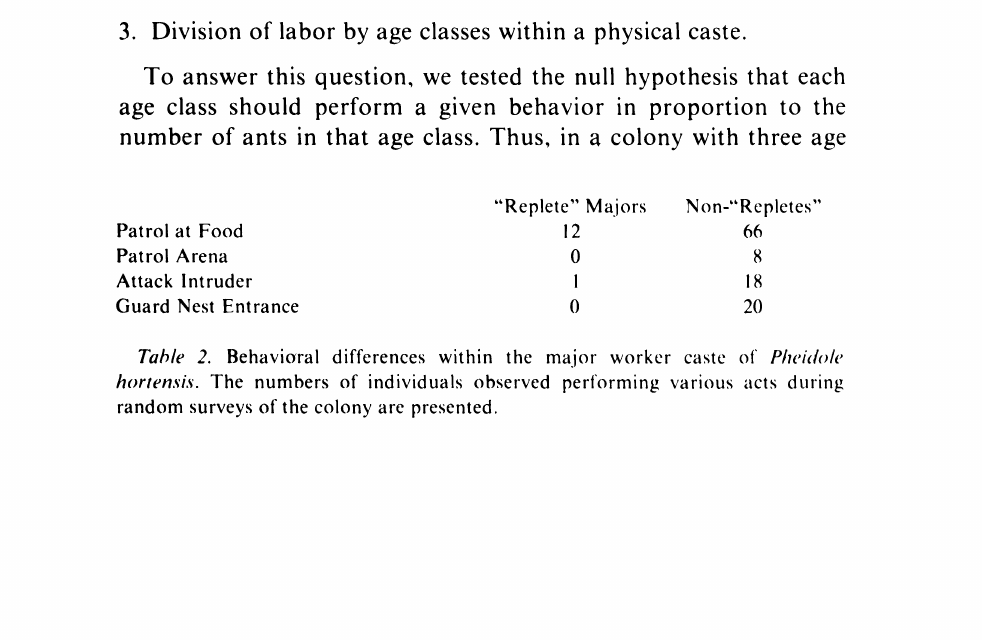
Table 2. Behavioral differences within the major worker caste of Pheihde hortensis. The numbers of individuals observed performing various acts during random surveys of the colony are